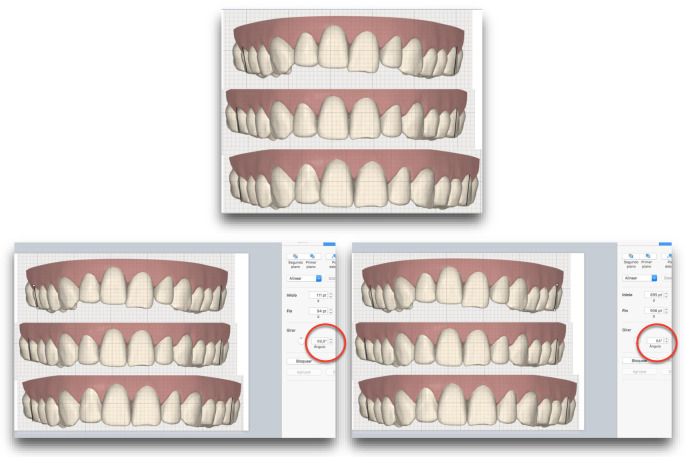
Images exported to Keynote software designed to measure angulation.